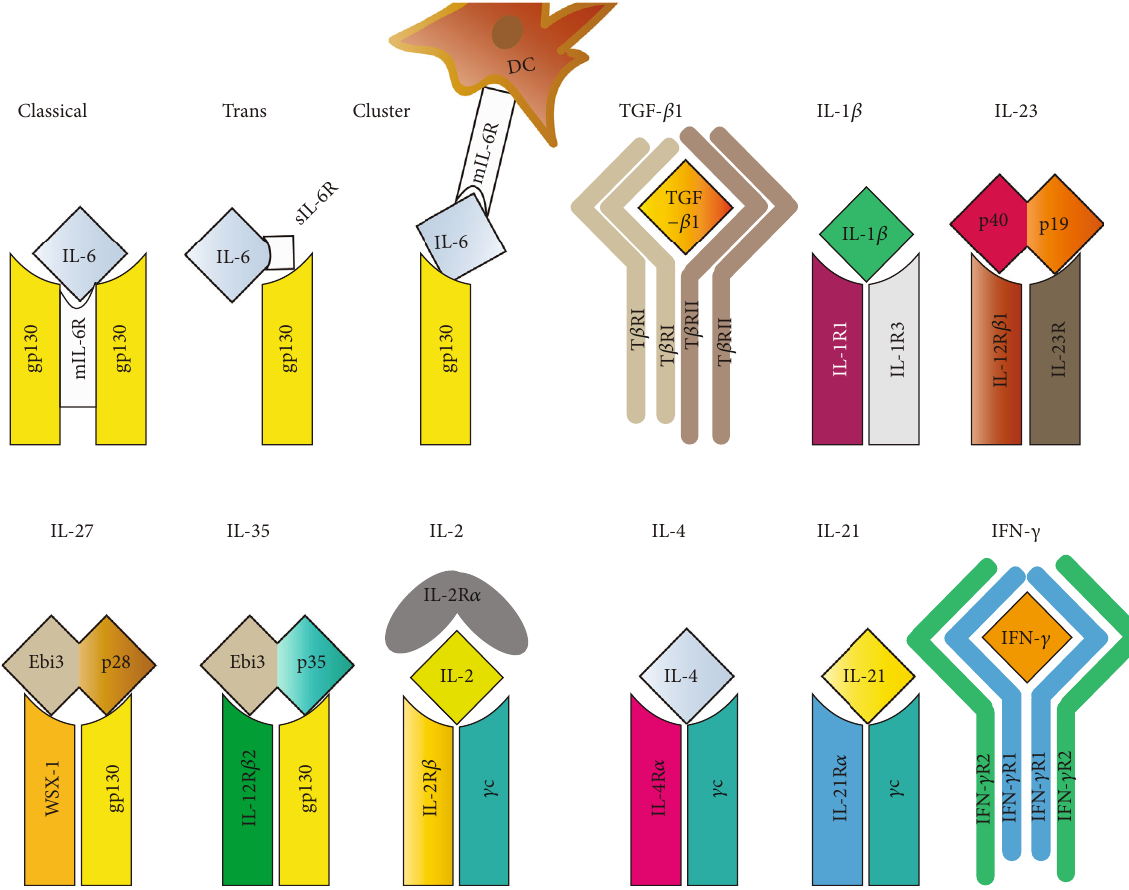
Figure 2: The structures of IL-6, TGF- β 1, IL-1 β , IL-23, IL-27, IL-35, IL-2, IL-4, IL-21, IFN- γ , and their receptors in CD4+ T